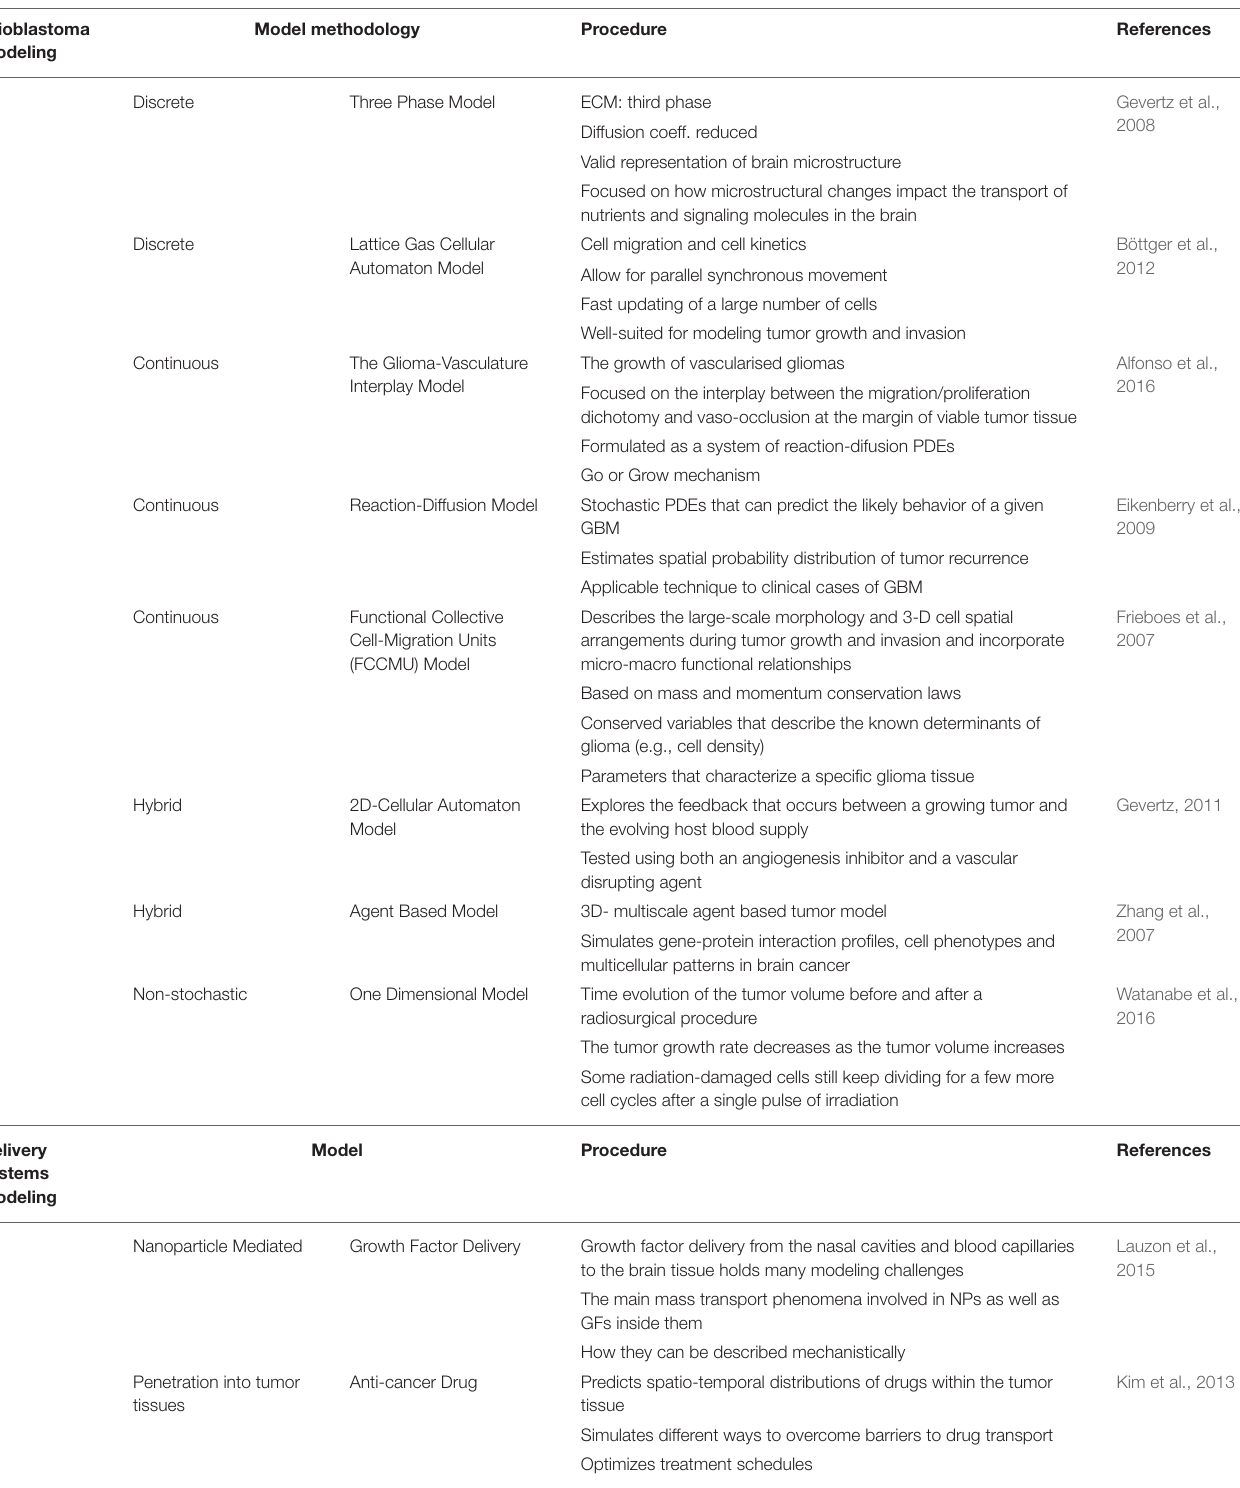
TABLE 2 | The summary of glioblastoma modeling and delivery systems modeling (ECM, Extra cellular matrix; Coeff., Coefficient; PDE, Partial differential equations; GBM, Glioblastoma; ODE, Ordinary differential equations). Glioblastoma